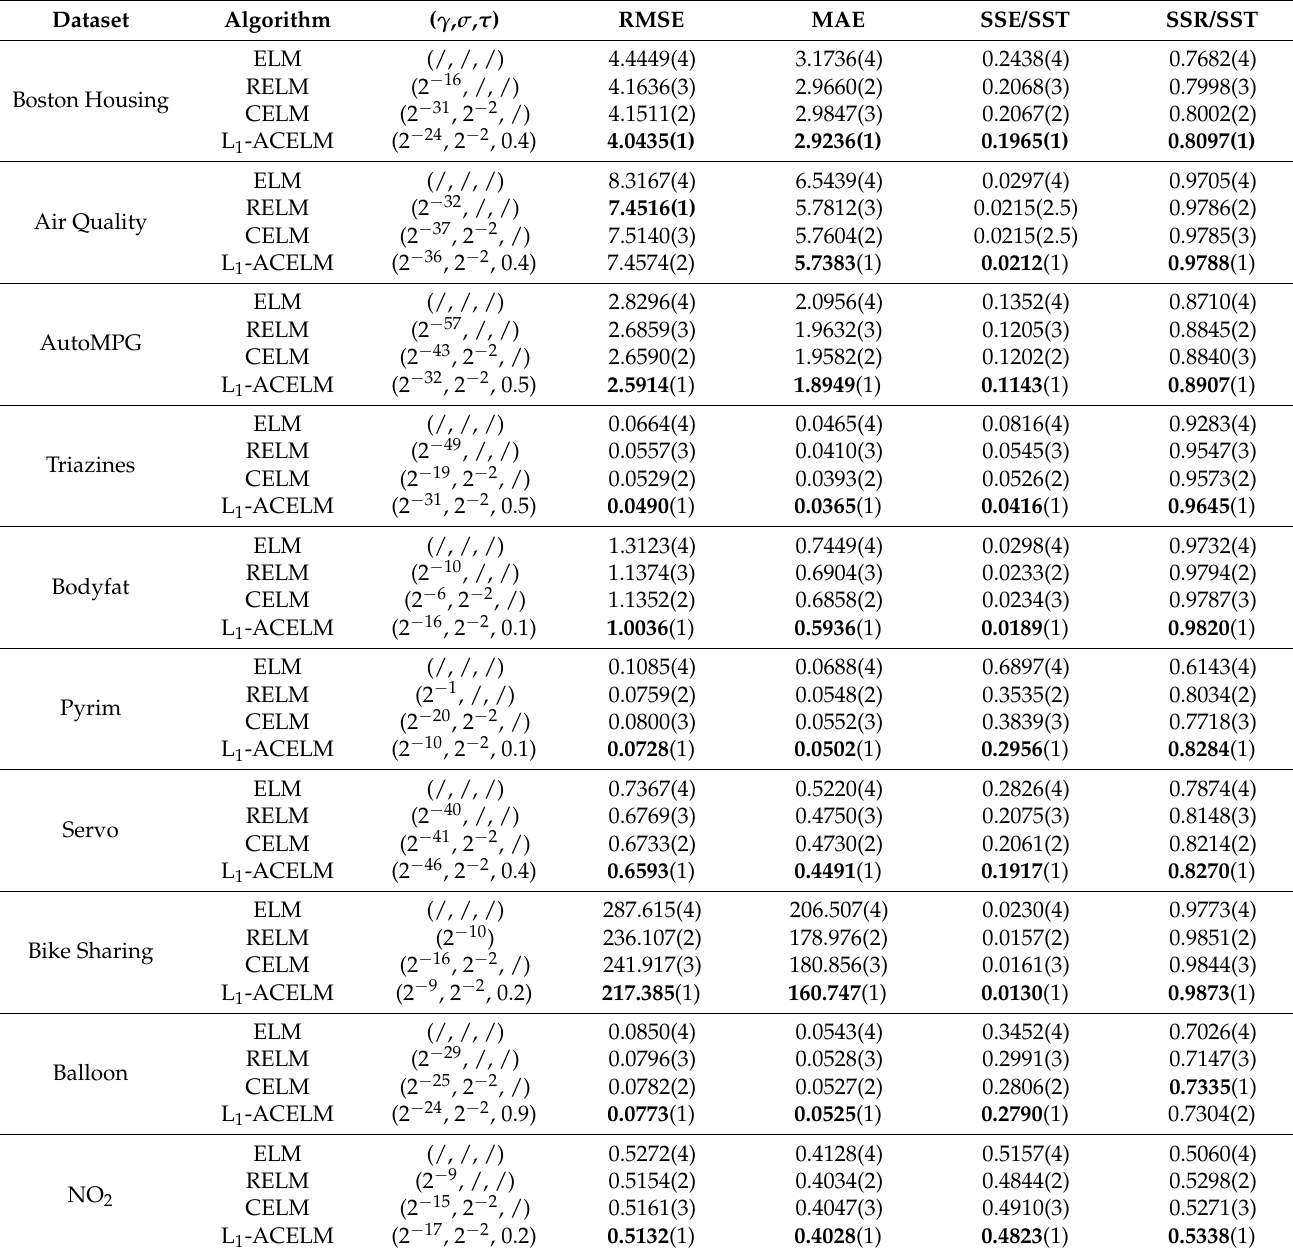
Table 4. Performance of different algorithms under noise-free